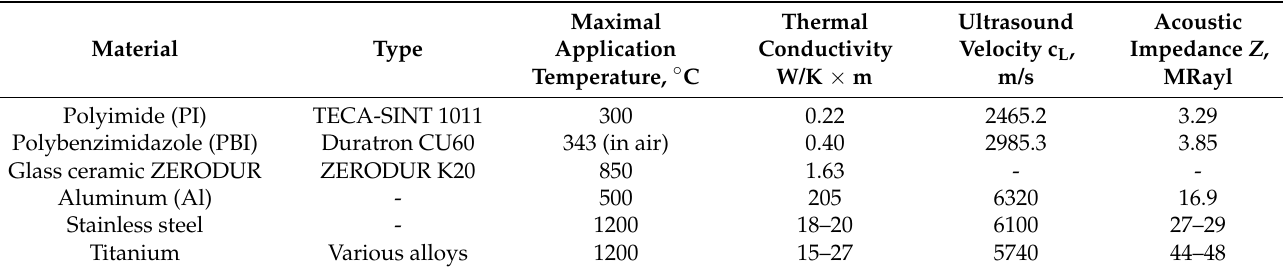
Table 1. Materials of buffer rods and their properties.